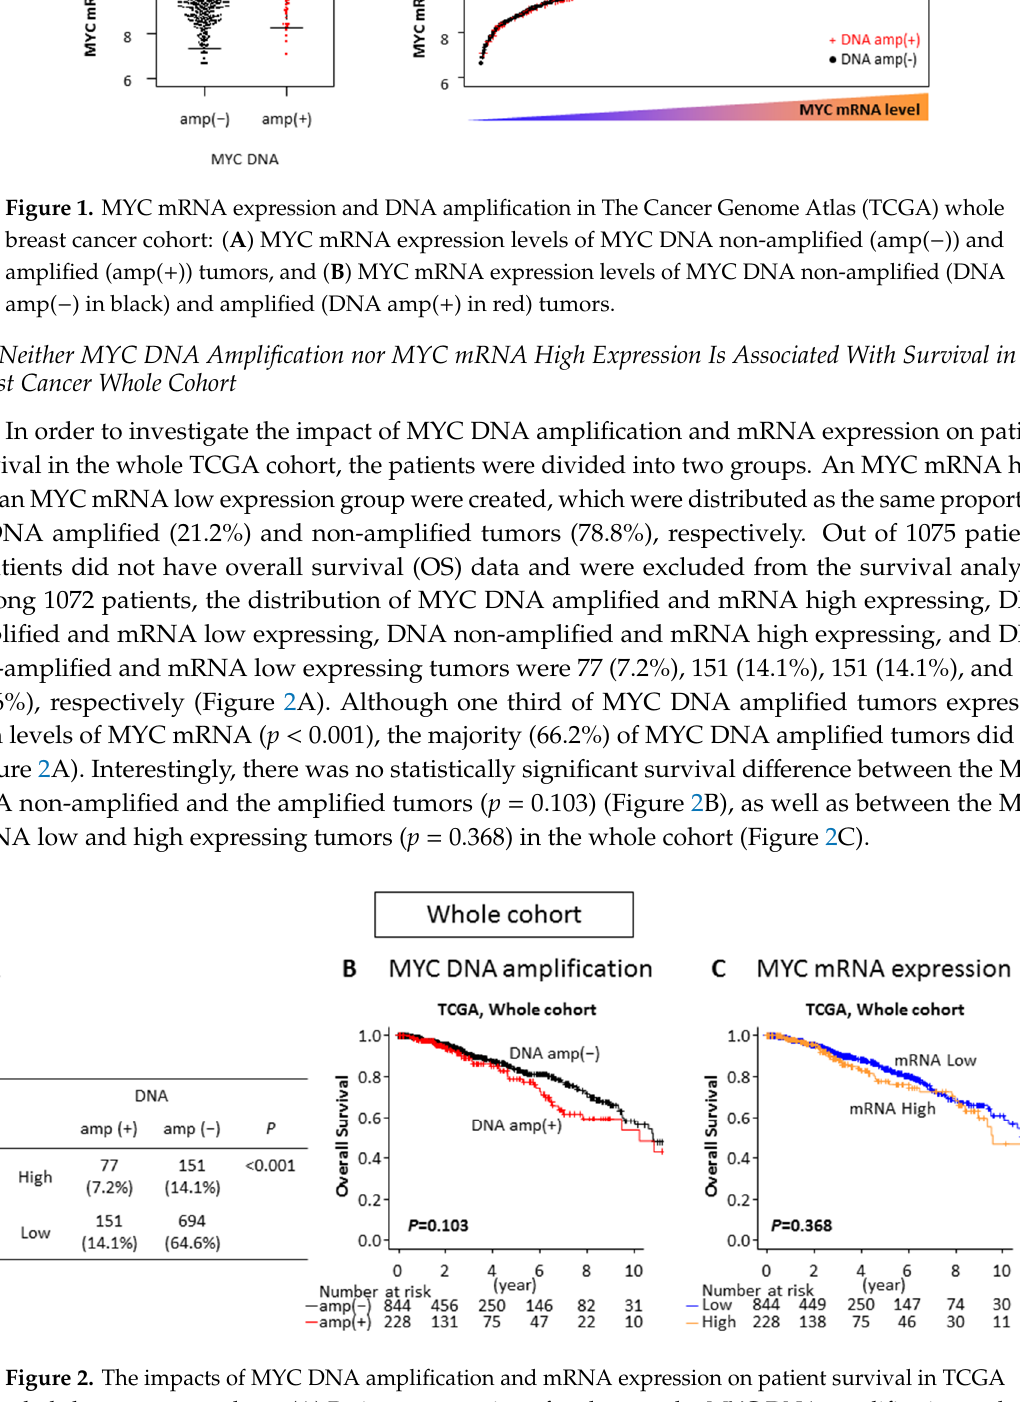
Figure 2. The impacts of MYC DNA amplification and mRNA expression on patient survival in TCGA whole breast cancer cohort. ( A ) Patients proportion of each group by MYC DNA amplification and mRNA expression. ( B ) Overall survival comparing the MYC DNA non-amplified (DNA amp( − ) in black) and amplified (DNA amp( + ) in red) tumors. ( C ) Overall survival comparing the MYC mRNA low (mRNA low in blue) and high (mRNA high in orange) expressing